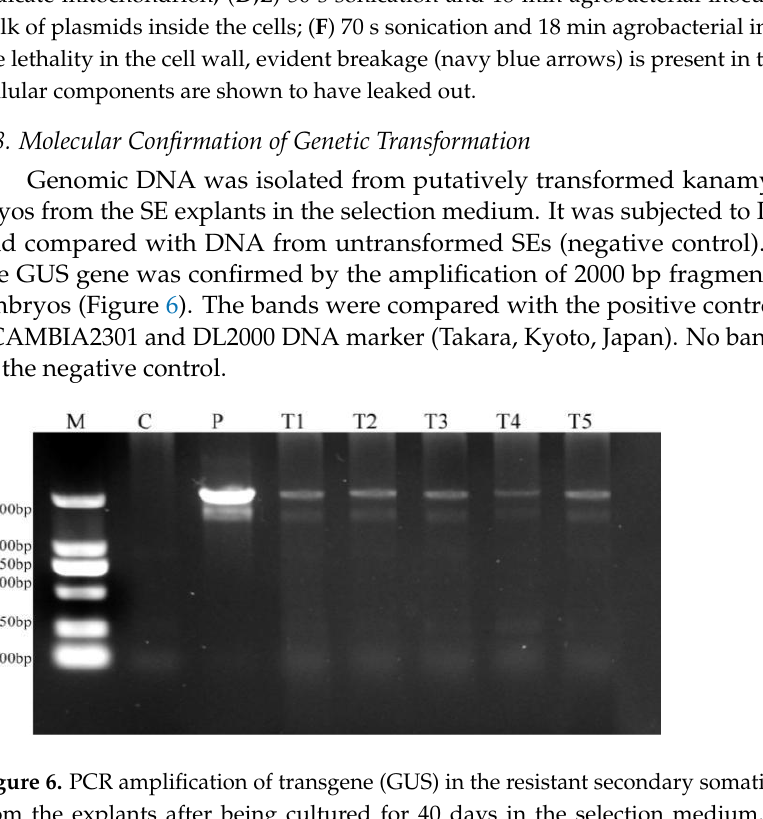
Figure 5. TEM analysis of cells of Agrobacterium -inoculated somatic embryos. ( A ) Control cells with normal internal structures, the cell wall and starch granules (yellow arrows) were evident and normal; ( B ) sonication effect on cellular structure, the intercellular space is disturbed (blue mark) and the arrangements of starch granules (yellow arrows) was also affected; ( C ) cells with normal agrobacterial infection showing very few numbers of plasmids (red circles) inside the cell wall, green marks indicate mitochondrion; ( D , E ) 50 s sonication and 18 min agrobacterial inoculation showing the bulk of plasmids inside the cells; ( F ) 70 s sonication and 18 min agrobacterial inoculation showing the lethality in the cell wall, evident breakage (navy blue arrows) is present in the cell wall, and all cellular components are shown to have leaked out.